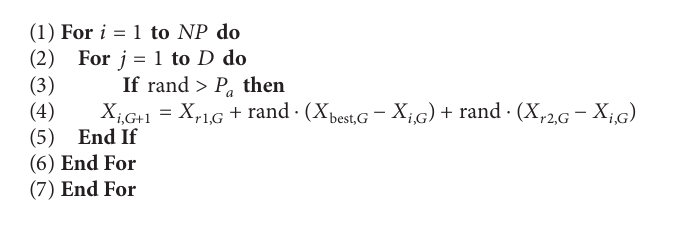
Algorithm 1: Population updating process.